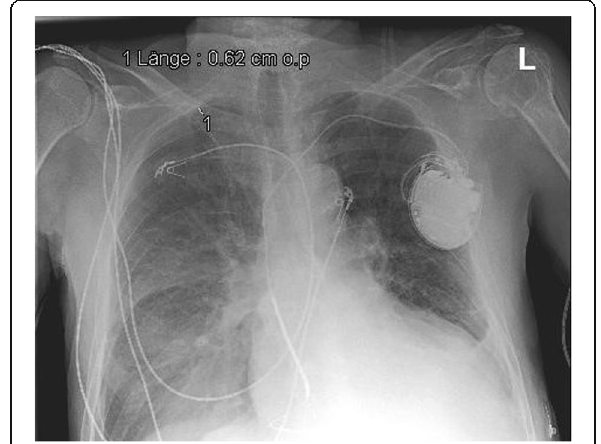
Fig. 2 X-Ray 03/27/2020, lunge after draining 1.1 l pulmonal